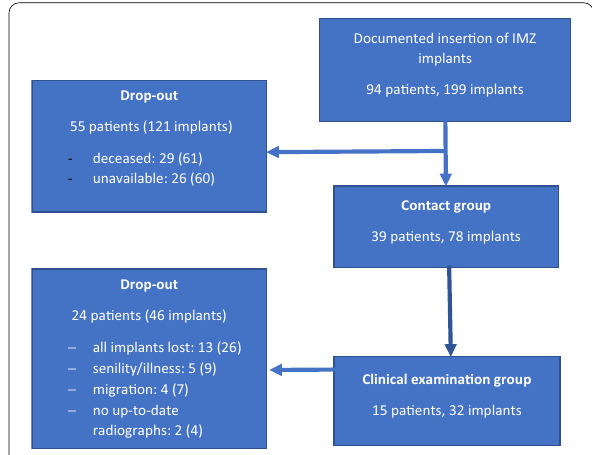
Fig. 2 Flow diagram of patient